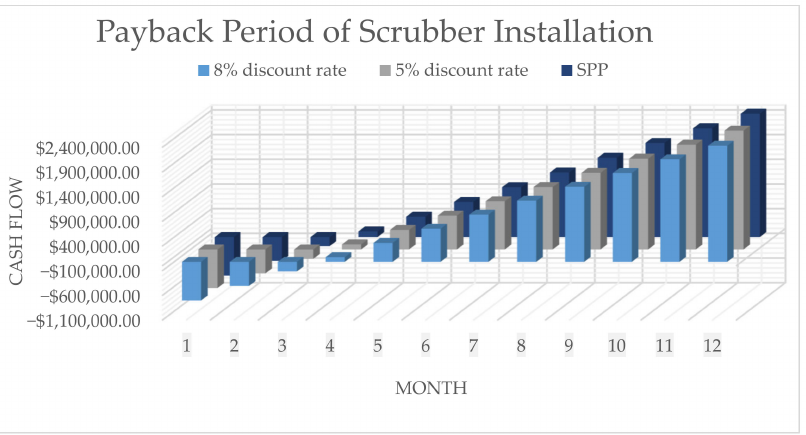
Figure 5. Cash flow and payback period of scrubber installation based on different discount rates. While the SPP is found at 0.30 years, the DPP is calculated at 0.34 and 0.37 years for